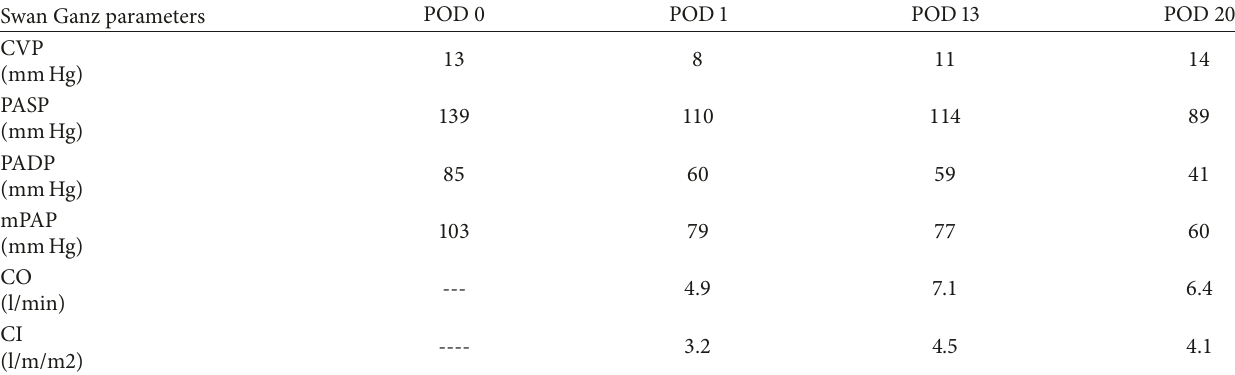
Table 1: Hemodynamic measurements obtained after cardiac arrest and insertion of extracorporeal membrane oxygenation. Swan Ganz